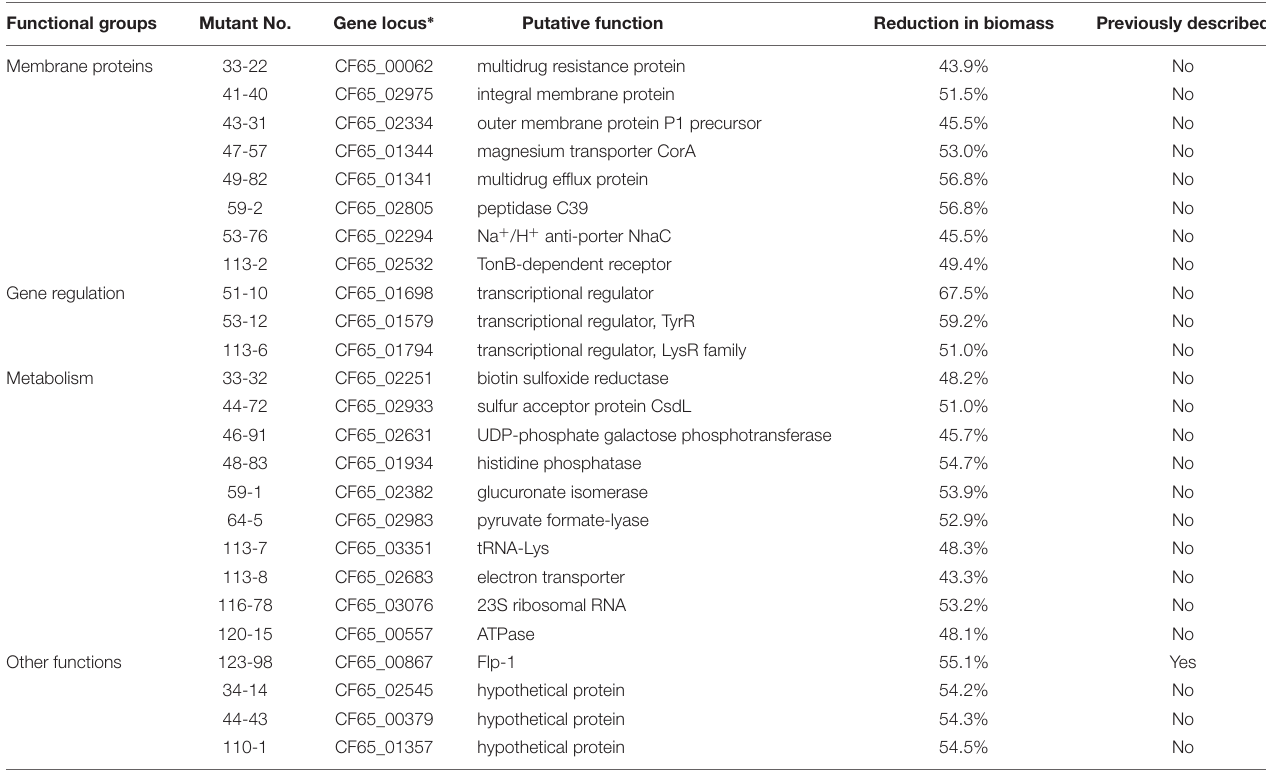
TABLE 1 | Transposon insertion sites in Aggregatibacter actinomycetemcomitans ATCC 700685 mutants with reduction in biomass. Functional groups Mutant